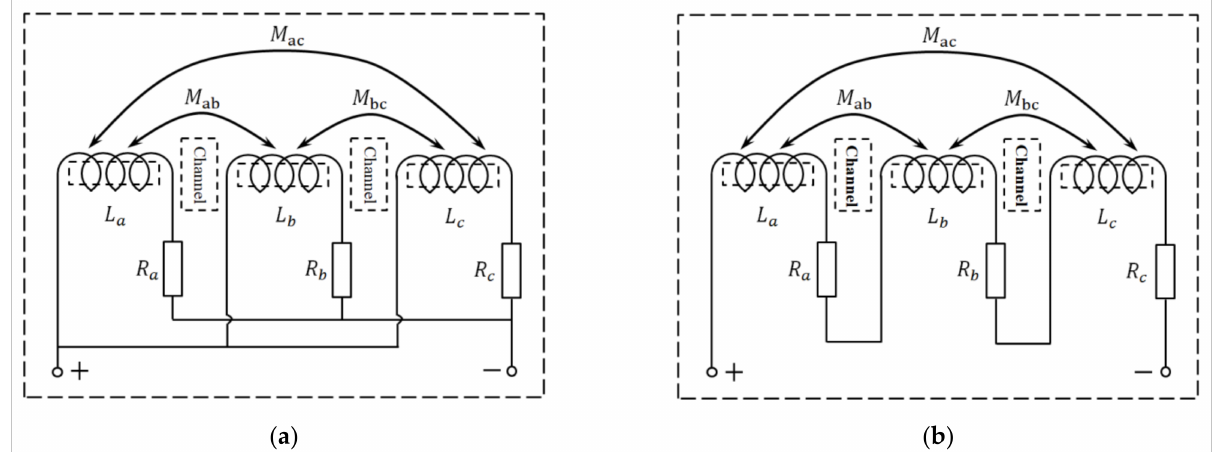
Figure 2. Coil connection in the same direction: ( a ) parallel connection; ( b ) series